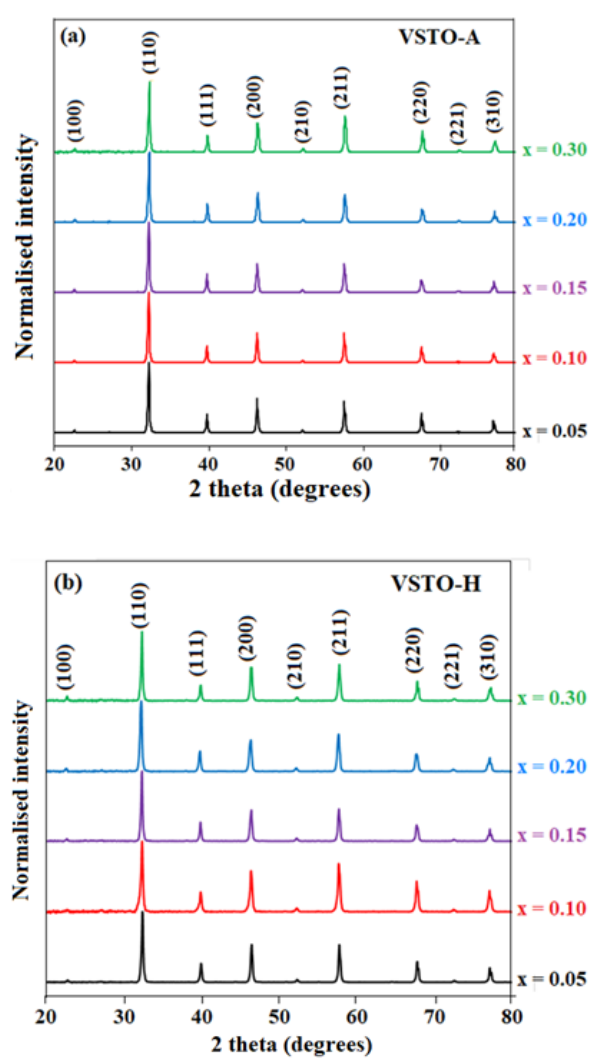
Figure 1. XRD patterns for ( a ) VSTO-A and ( b ) VSTO-H ceramics.